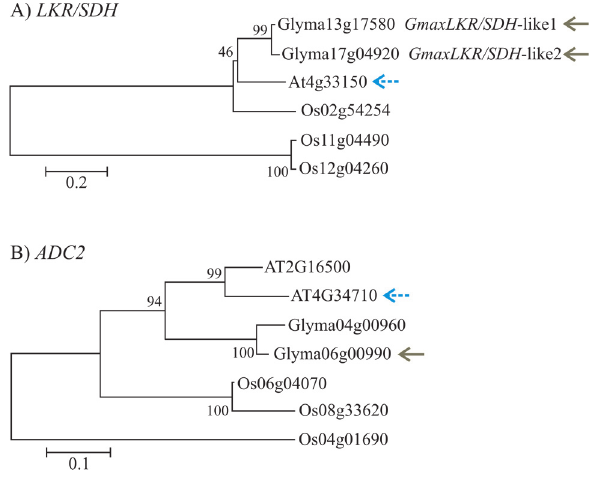
Figure3 -Dendrogramusingagenemodelofdroughtresponsivegenesin Arabidopsis thaliana , Oryza sativa and Glycine max based on the amino acidsequences.(A)Dendrogramof LKH/SDH -like1and LKH/SDH -like2, and (B) of ADC2- like 1. The green solid arrows indicate the soybean can- didates and the blue dotted arrows the respective Arabidopsis reference genes. Bootstrap values (1,000 replications) are indicated at the base of each branch.